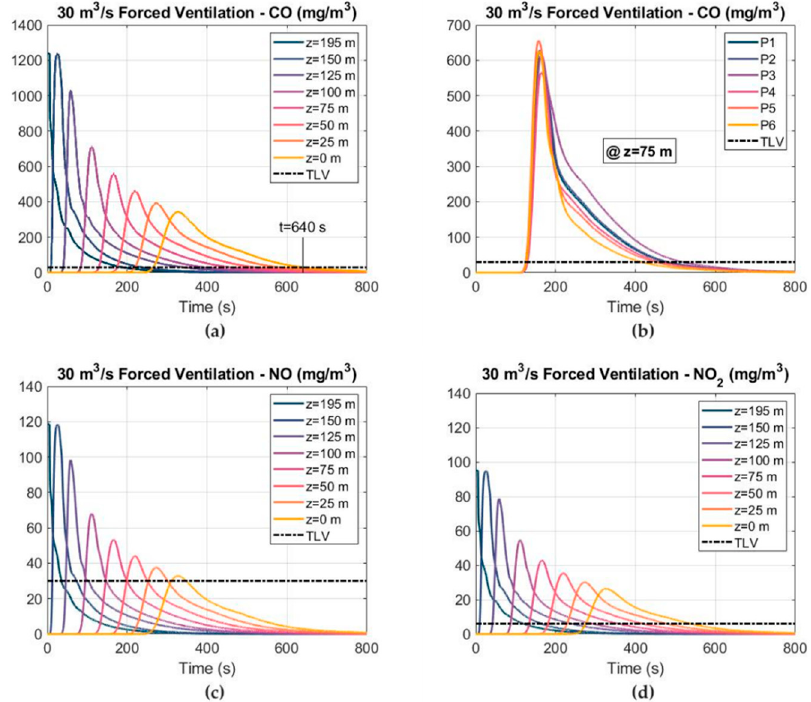
Figure 17. Distribution of the toxic gas mass concentrations and TLVs at different cross sections, considering an airflow of 30 m 3 s − 1 and the forced ventilation mode: ( a ) CO mass concentration; ( b ) CO mass concentration at different points in the cross section of Z = 75 m; ( c ) NO mass concentration; and ( d ) NO 2 mass concentration.